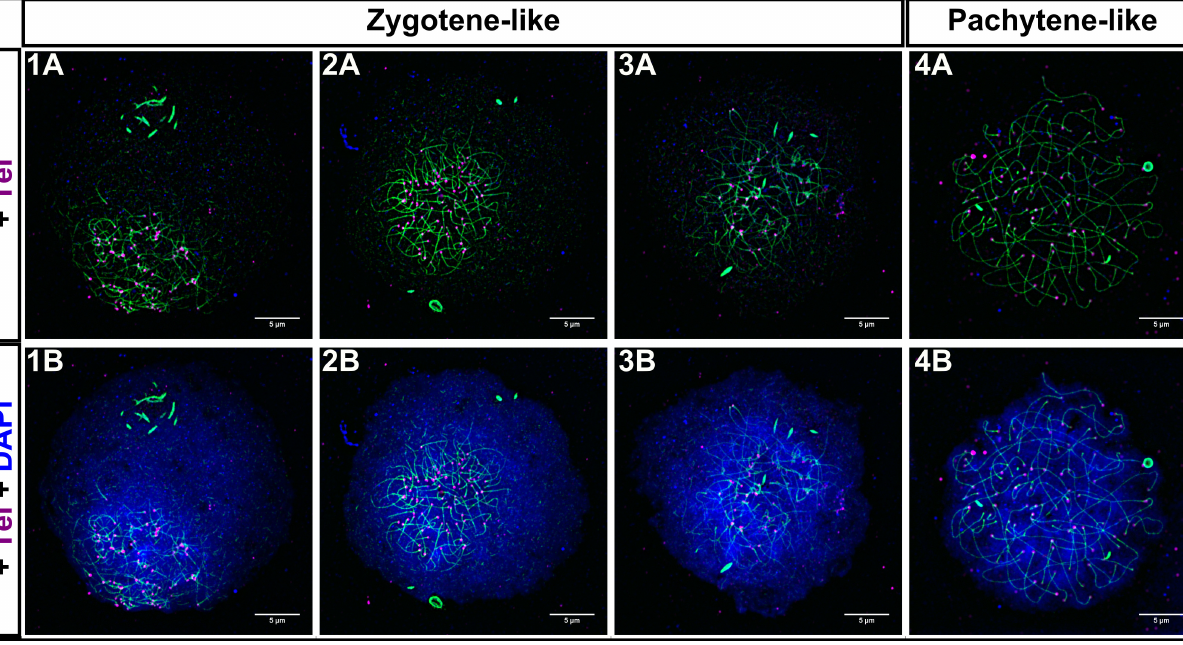
PLOS Genetics | https://doi.org/10.1371/journal.pgen.1007730 January17,